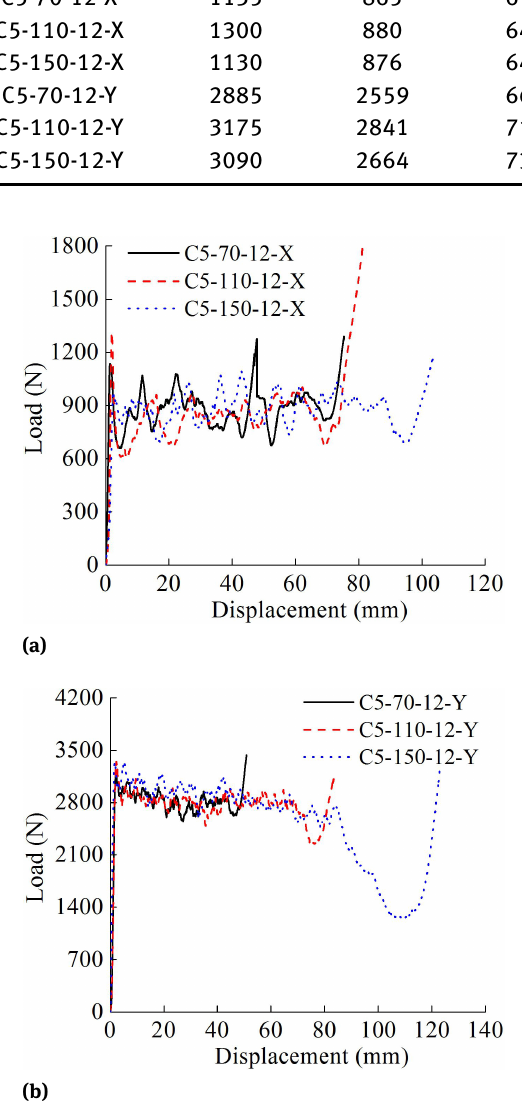
The initial peak force and the mean crush force of reg- ular pentagon paper corrugation tubes along X and Y direc- tion with three kinds of length are illustrated in Figure 15. For the tube length of 110mm, both the initial peak force and the mean crush force are the largest. The results of en- ergy absorbing characteristics with different tube lengths are shown in Figure 16. The total energy absorption, unit area energy absorption and stroke efficiency of tubes along X and Y direction all gradually improve, the reason are no change of bearing area and the increase of compressible distance. However, the change of the specific energy absorp- tion is not obvious because the gross mass of the structure increase at the same